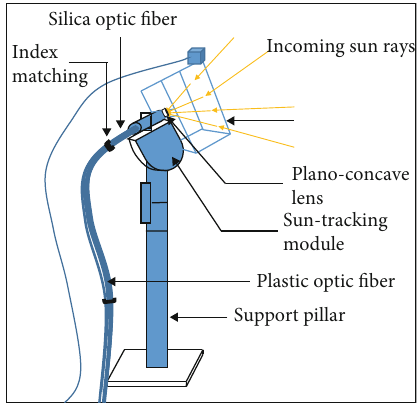
Figure 4: Physical layout of Fresnel lens daylighting system showing ray-tracing and sun-tracking module (source: adapted from [46]).